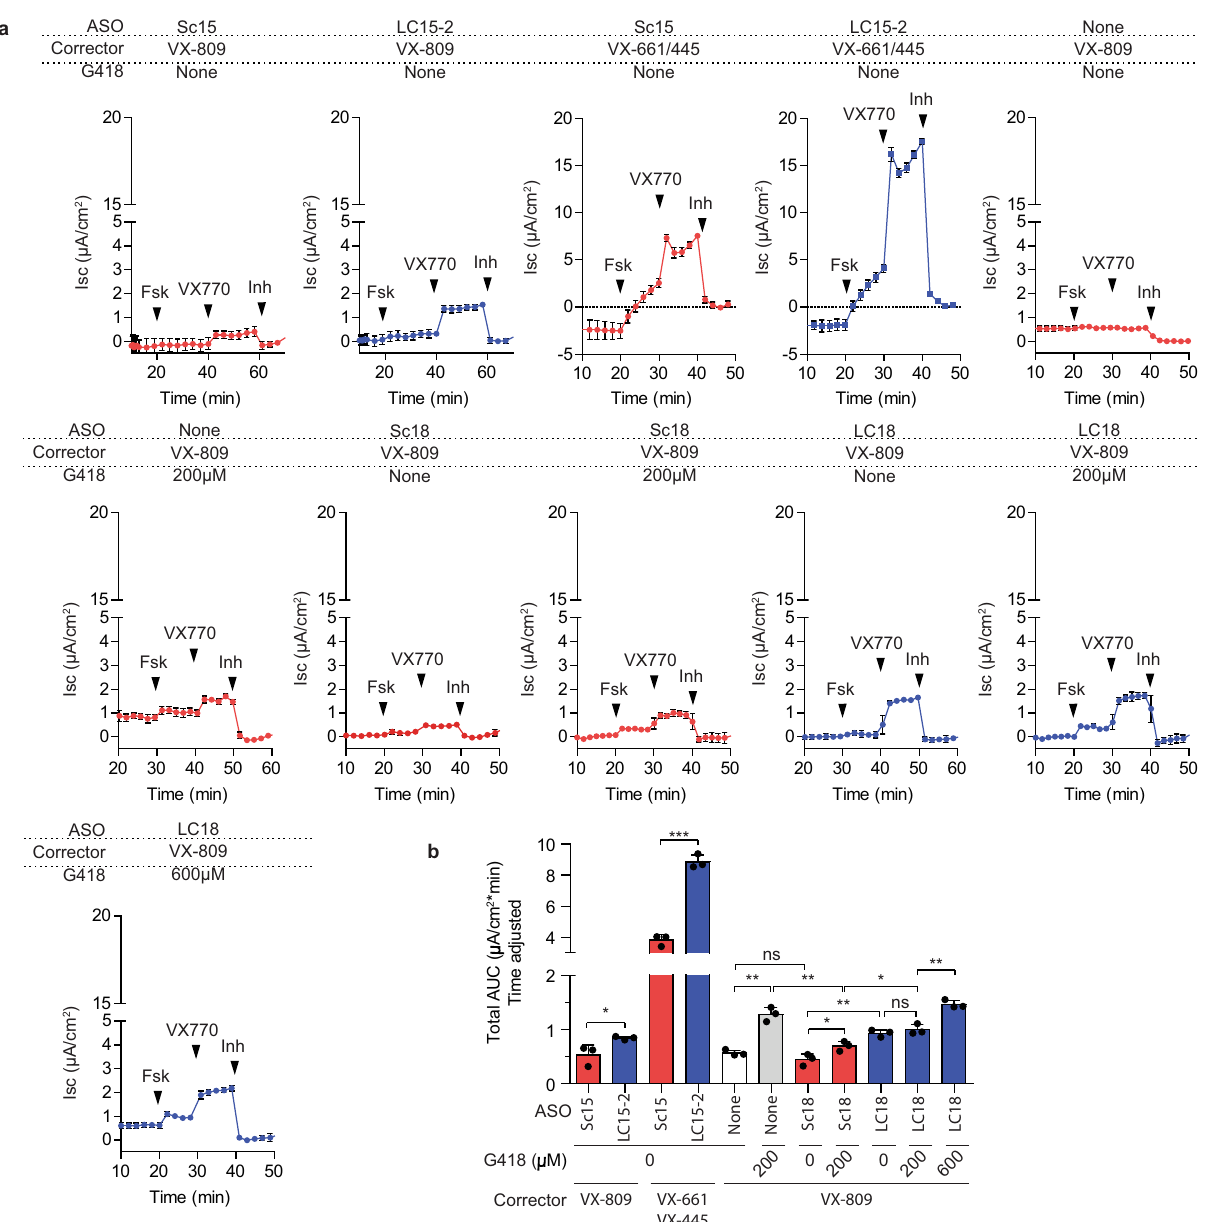
Fig. 5 Effect of the lead ASO cocktail on CFTR-W1282X protein expression. a Average traces ( n = 3) from Ussing-chamber assay of 16HBE-W1282X cells treated with various combinations of 20 μ M ASOs (Sc15, Sc18, LC15-2, or LC18), CFTR correctors (3 μ M VX-809 or 3/3 μ M VX-661/445), and G418 (200 or 600 μ M), as indicated above each trace. All VX-809, VX-661/445, and G418 treatments were started 24 h prior to the assay. Black arrowheads show when Fsk, VX-770, or CFTR inhibitor 172 was added. b Total AUC in (a) divided by the total duration of each experiment (i.e., the time between forskolin treatment and CFTR inhibitor 172 treatment). Abbreviations as in Figs. 1 and 4. Data are represented as mean values ± SD. All data points represent independent biological replicates. n = 3 for all treatments. n.s. P > 0.05, * P < 0.05, ** P < 0.01, *** P < 0.001, two-tailed Student ’ s t -test. Source data are provided as a Source Data